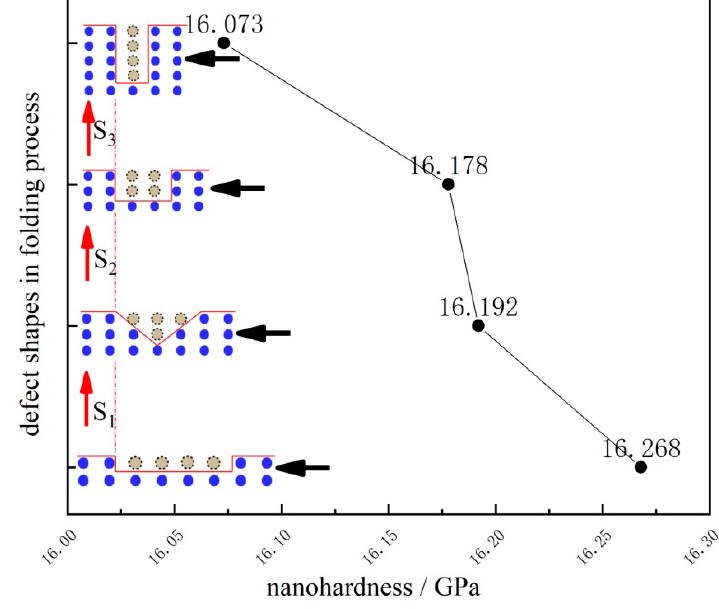
Figure 4. Nanohardness curve in defect folding process.